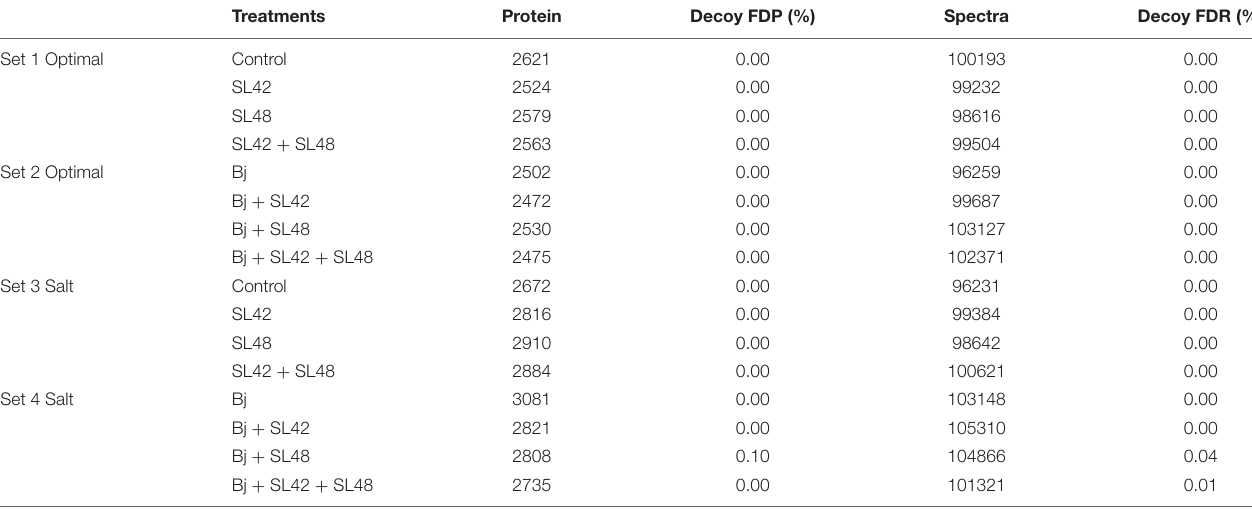
TABLE 2 | Total number of proteins identified at 99% protein probability and total spectra at 95% peptide probability, with two minimum peptides. Treatments